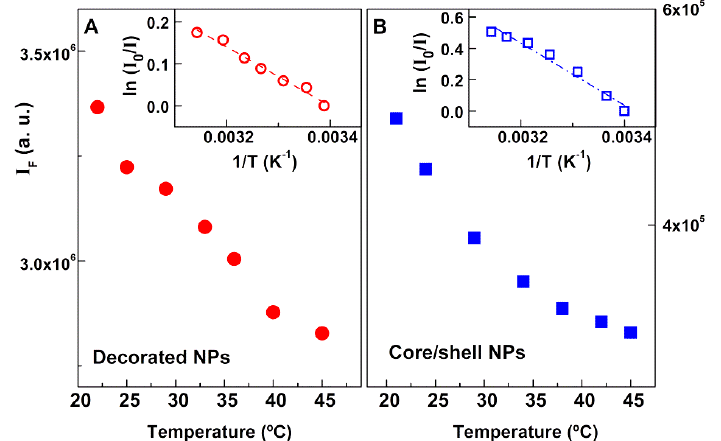
Figure 13. Fluorescence intensity of Rhodamine B as a function of temperature, for magnetoliposomes containing magnetic/plasmonic nanoparticles. Inset: Plots of 𝑙𝑛(𝐼 F0 𝐼 F ⁄ ) versus nanoparticles. ( B ) Core / shell